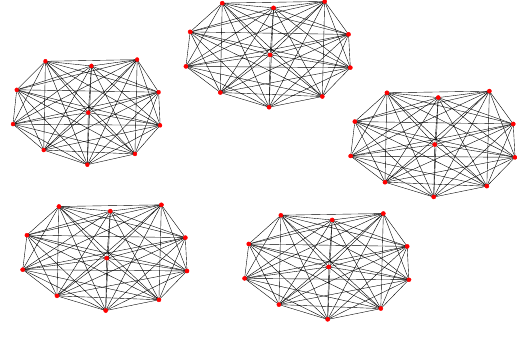
Figure 7. Mission layer of Structure 1.